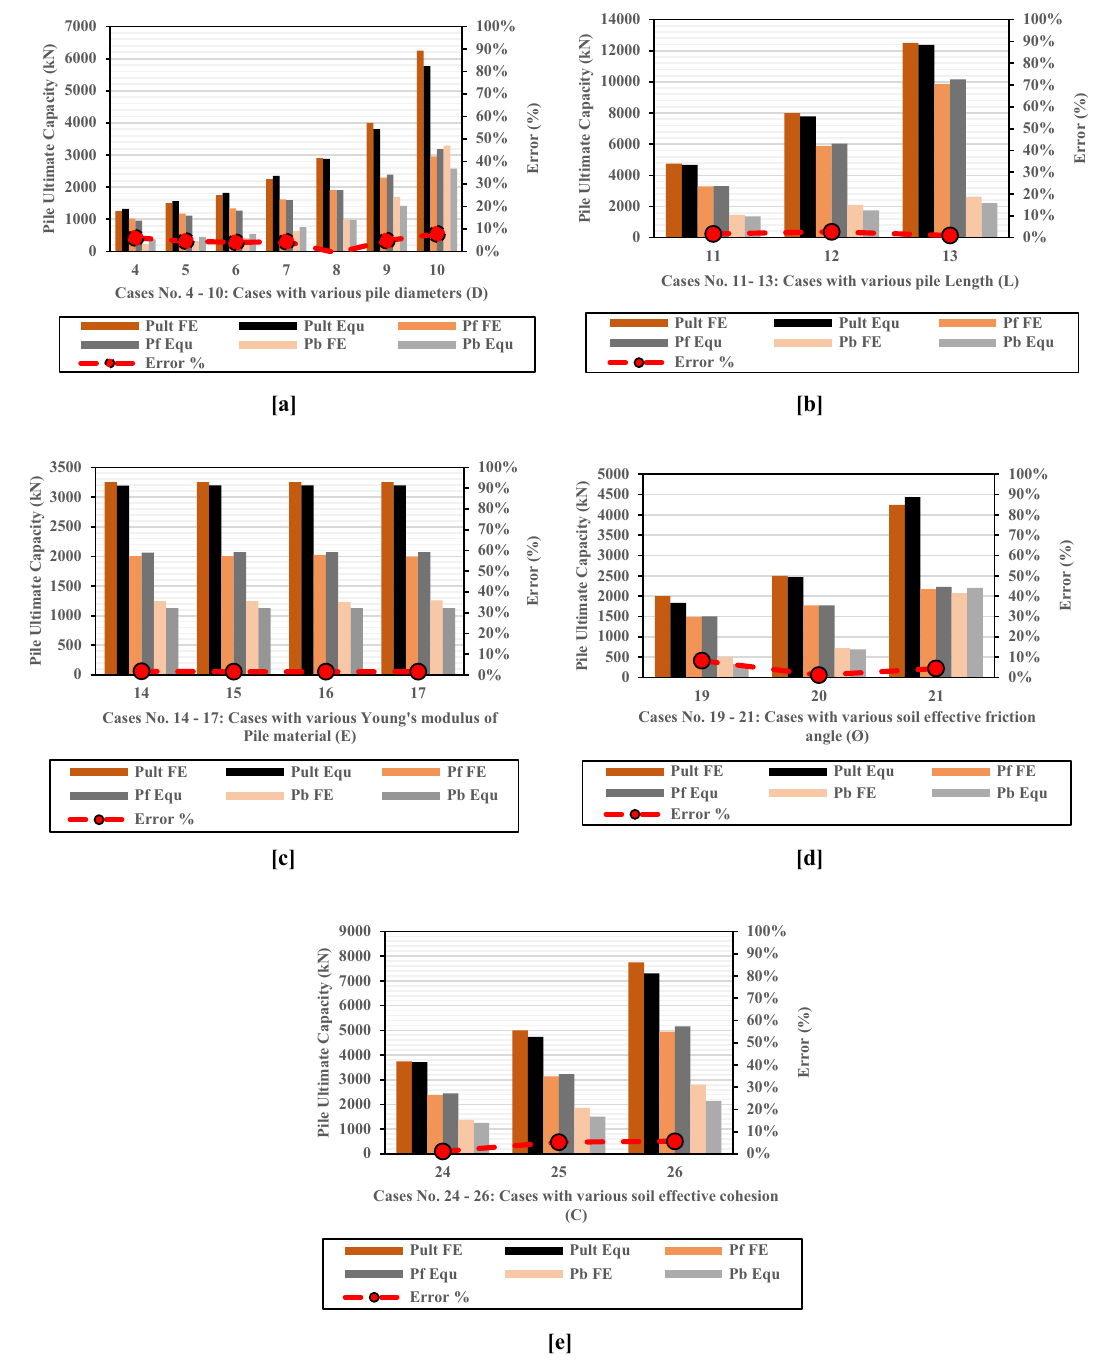
Figure 16. Comparison between numerical results and the LDBP ultimate pile capacity calculated using the proposed Approach. ( a ) Cases with various pile diameters ( b ) Cases with various pile Length ( c ) Cases with various Young’s modulus of Pile material ( d ) Cases with various soil effective friction angle ( e ) Cases with various soil effective